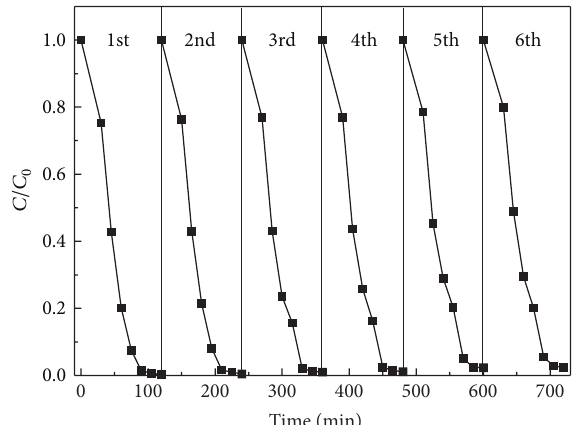
Figure 7: Recycling photocatalytic test of Bi-TiO 2 /SBA-15 calcined at 550 ∘